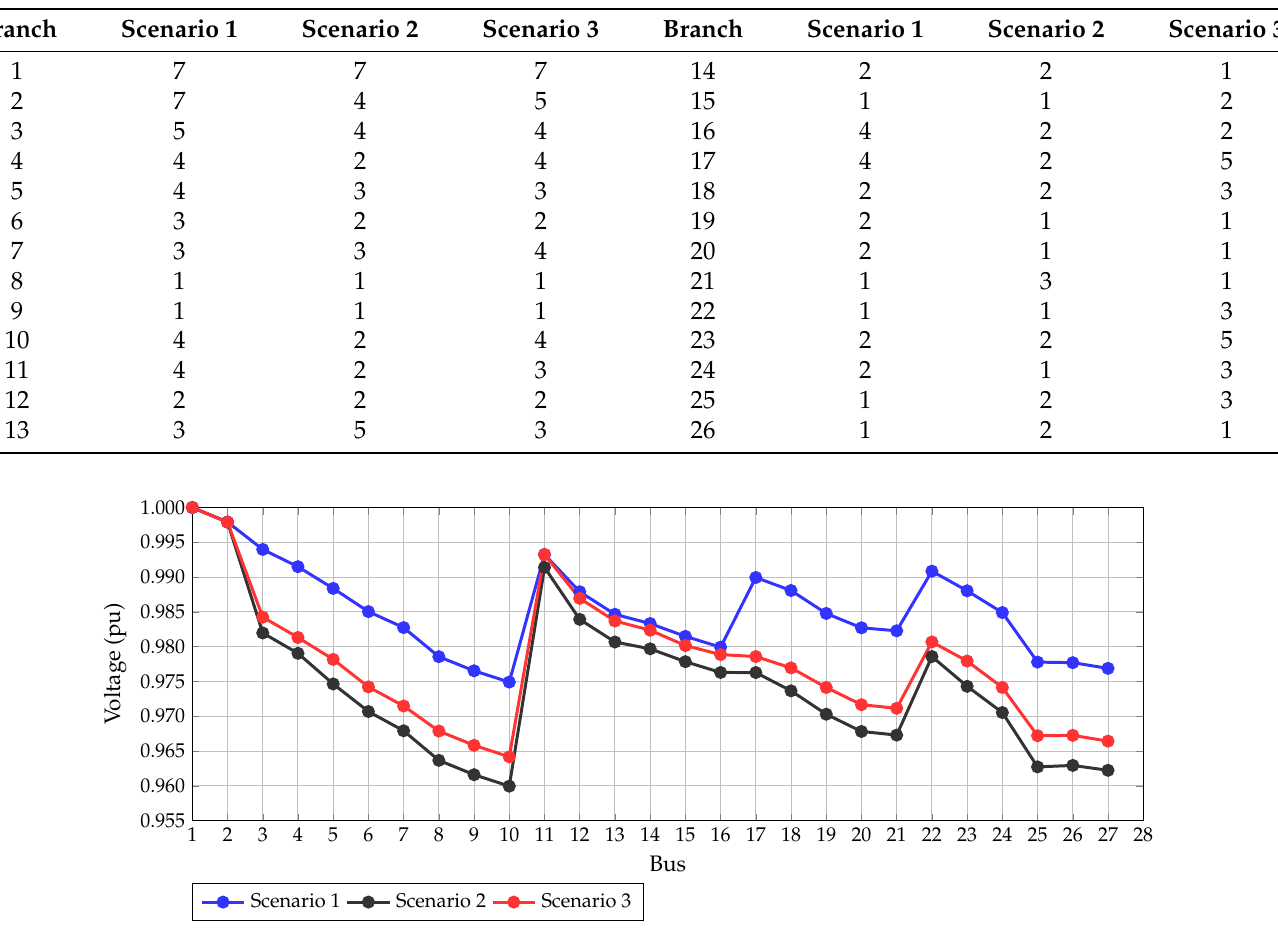
Figure 8. Voltage profile at each node for the hour of maximum demand in the three stages of case 1 of test system 2.